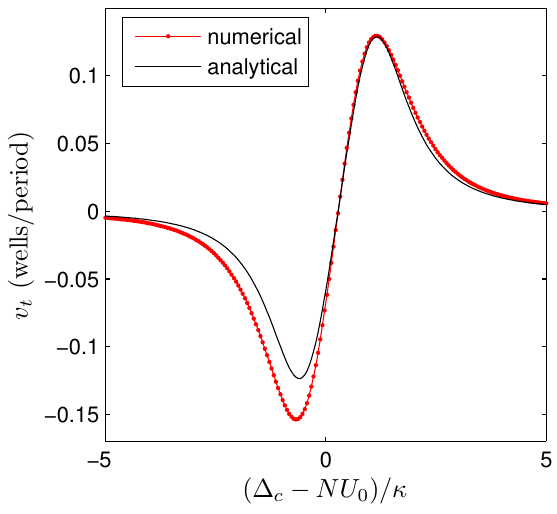
Figure 5. Comparison of the transport velocity as a function of the cavity-driving laser detuning calculated from the numerical simulation and using the analytical expression Equation (34). System parameters are as introduced in Figure 2a with η varied to maintain an initial lattice depth of